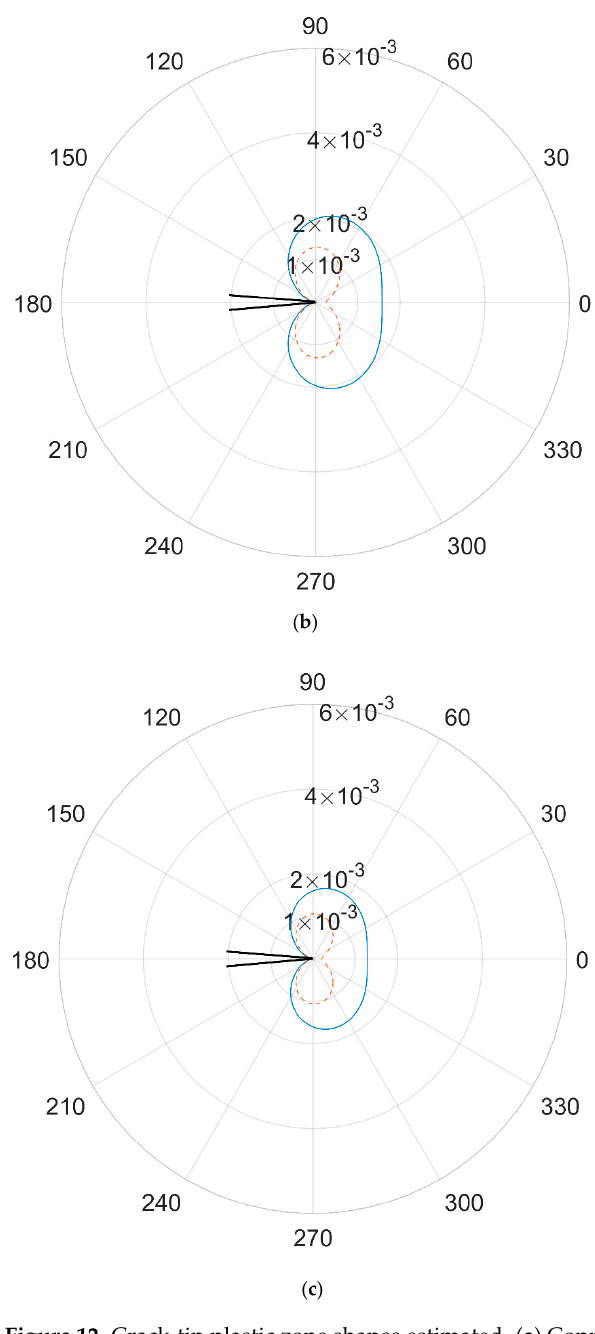
Figure 12. Crack-tip plastic zone shapes estimated. ( a ) Copper. ( b ) 90W-9Ni-Co. ( c ) W-25Re. As presented in Figure 12, the plain strain condition suppresses yielding, resulting in a smaller plastic zone when compared with the plain stress. The maximums of r ( θ ) for the three kinds of materials are listed in Table 10. For the plane stress condition, the maximum r ( θ ) for plane stress can reach 58 mm for copper, while for the plane strain, the value could only reach 36 mm. For the tungsten alloy, the values of r ( θ ) are much lower than copper. The maximum r ( θ ) is about 17~21 mm, while for plane strain the values reduce to 1 mm. The maximum of r ( θ ) for the plane strain of tungsten alloys is consistent with the values of d y , which indicates the damage tolerance of the plastic